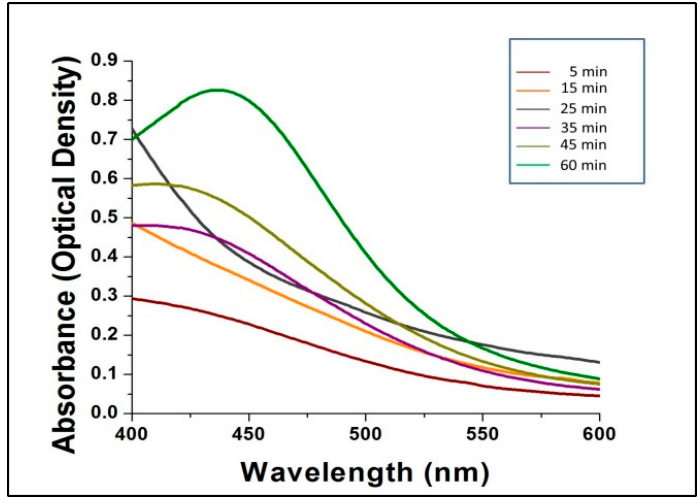
Figure 2. The ultraviolet-visible spectra of silver nanoparticles (AgNPs).